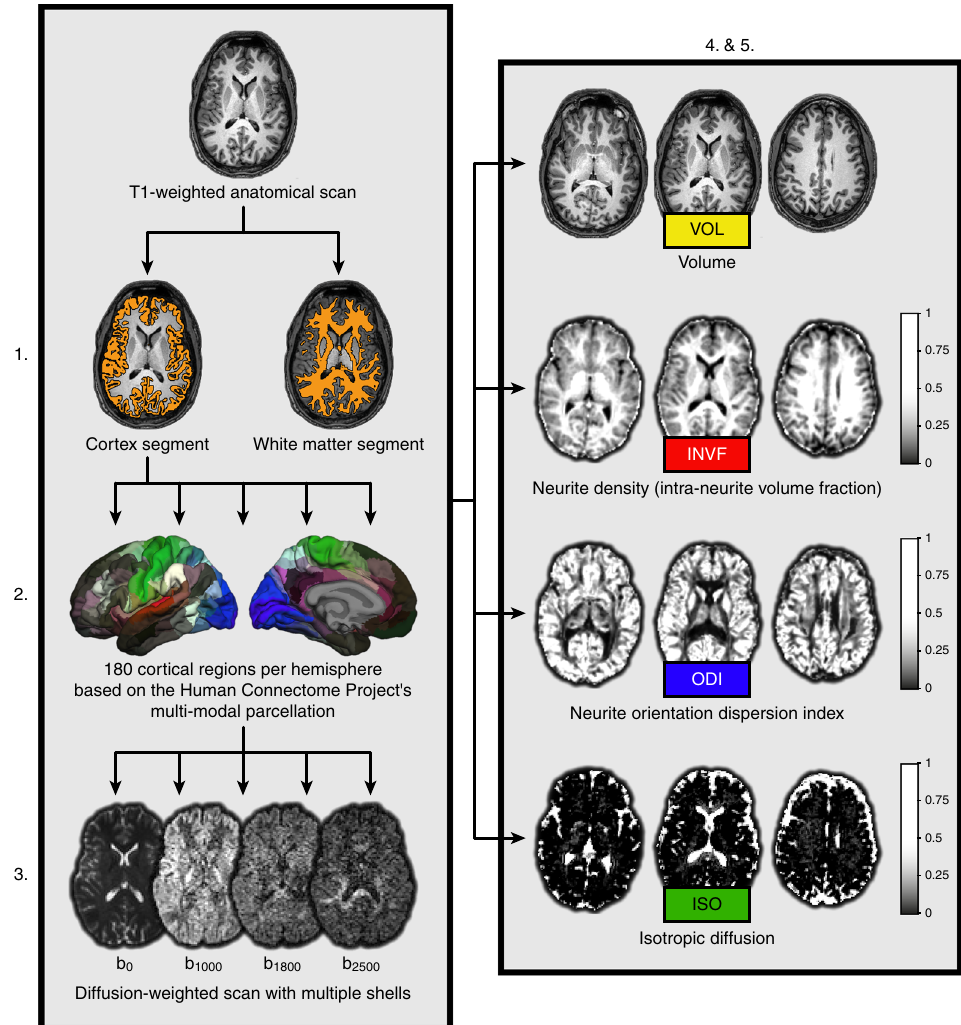
Fig. 1 Methodological sequence for the estimation of brain properties. First, T1-weighted anatomical images were partitioned into two segments including the overall cortex and white matter of the brain, respectively. Second, the cortical segment was further partitioned into 180 regions per hemisphere based on the multi-modal parcellation scheme provided by the Human Connectome Project. Third, both segments and the cortical brain regions were linearly transformed into the native space of the diffusion-weighted NODDI images. Fourth, mean values of different macrostructural and microstructural measures (volume estimates and NODDI coef fi cients) were computed for the overall cortex and white matter using the respective segments. Fifth, at the level of single brain regions, volume estimates and NODDI coef fi cients from homotopic brain regions were averaged across both hemispheres resulting in 180 mean values for each macrostructural and microstructural measure,